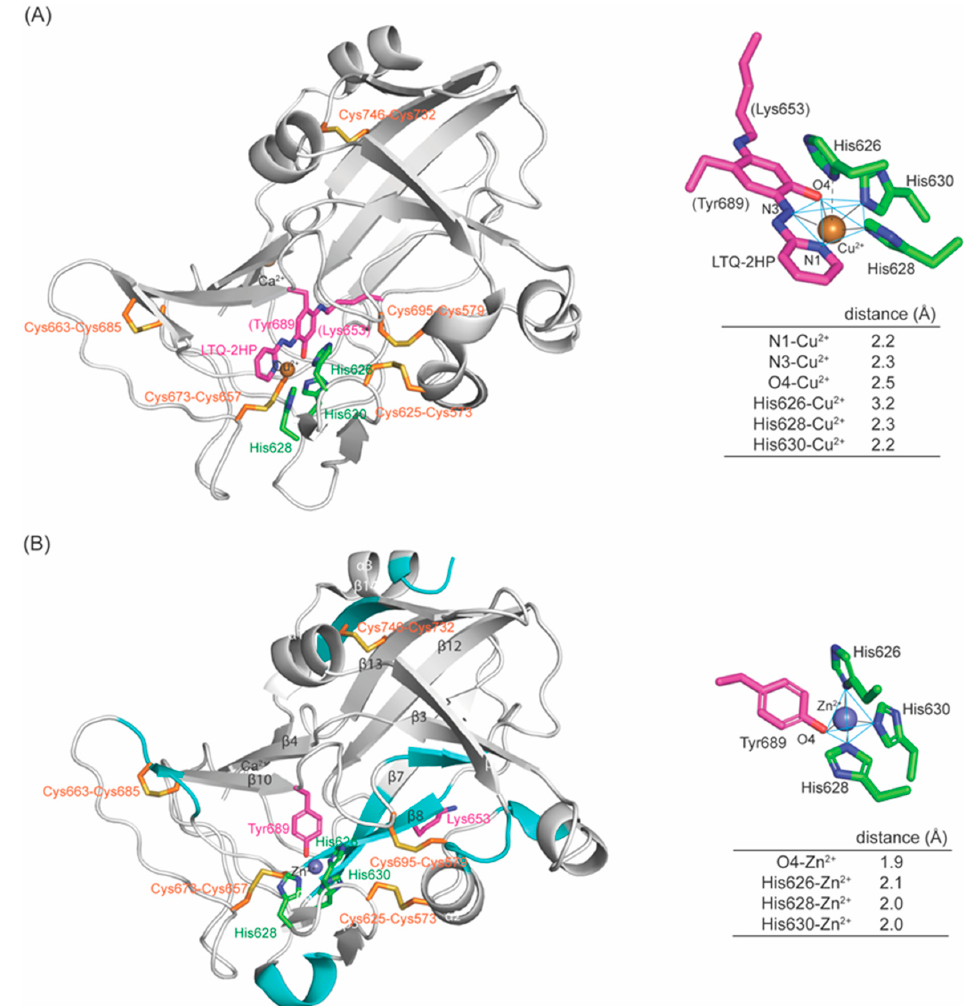
Figure 10. Comparison of amine oxidase domains and metal − binding sites of the 3D − modeled 2HP − inhibited LOXL2. ( A ) and the crystal structure of Zn 2+ − bound precursor (PDB:5ZE3) ( B ). Overall structures are very similar (RMSD = 1.347). In 3D − modeled structure ( A ), the cyan − colored secondary structure features in the precursor ( B ) are missing (having become loops). In the 2HP − ihibited LOXL2 ( A ), the Cu 2+ − coordination environment is a distorted square pyramidal with O4 − Cu 2+ in a Jahn − Teller axis and N1 and N3 of LTQ − 2HP and His628 and His630 comprising the square bottom. In the precursor structure ( B ), Zn 2+ is in tetrahedral coordination geometry having O4, His626, His628 and His630 at each tip of the tetrahedron. The cysteine − paring pattern of the five disulfide bonds are totally conserved in both structures.